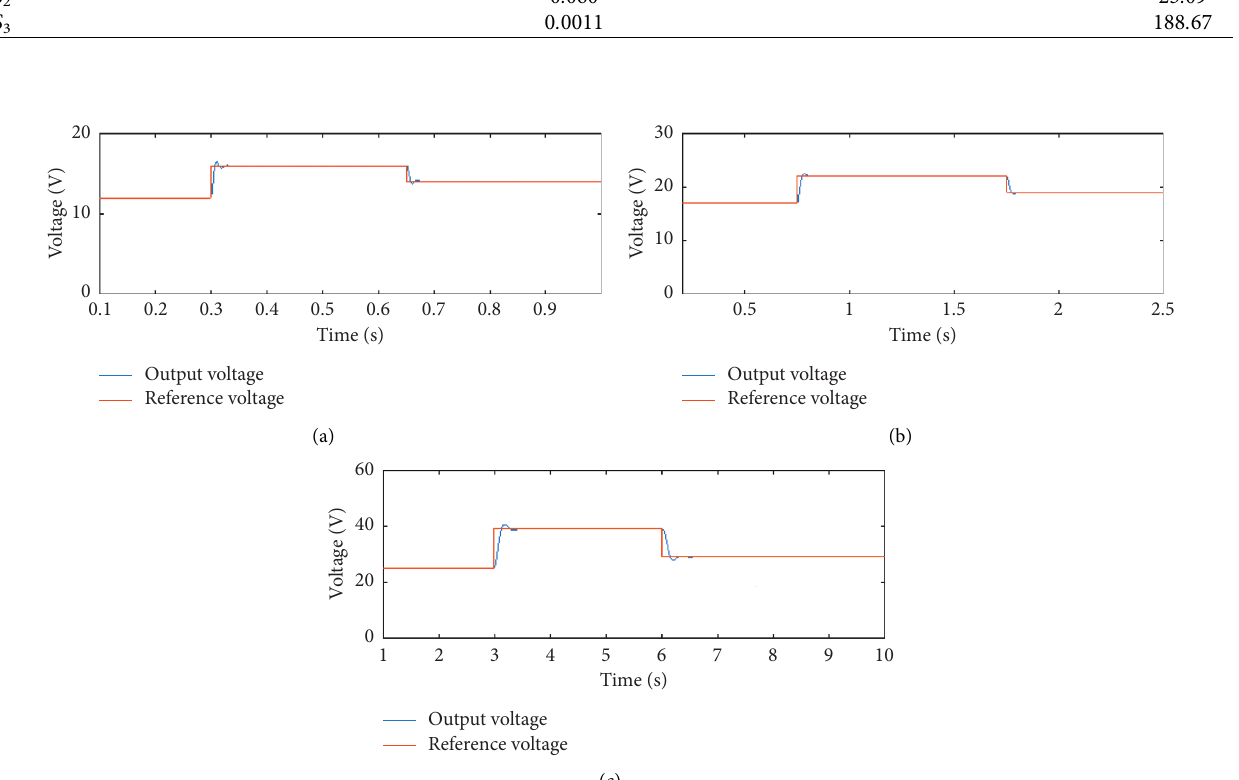
Figure 12: The closed-loop response with (a) PI 1 , (b) PI 2 , and (c) PI 3 controllers to reference voltage change. (a) 12-16-14V, (b) 17-22-19V, and (c) 25-39-29